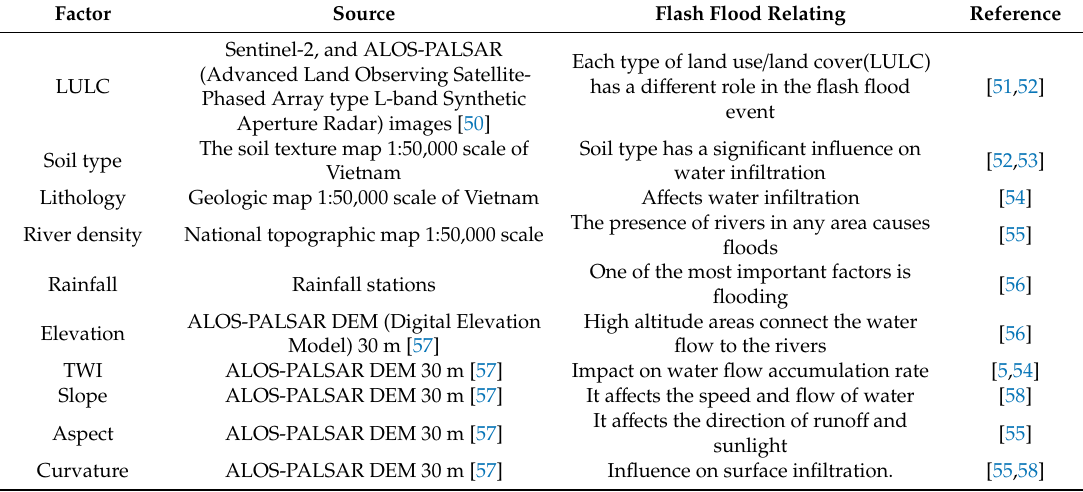
Table 1. Geospatial data sources used for the flash flood susceptibility mapping in this